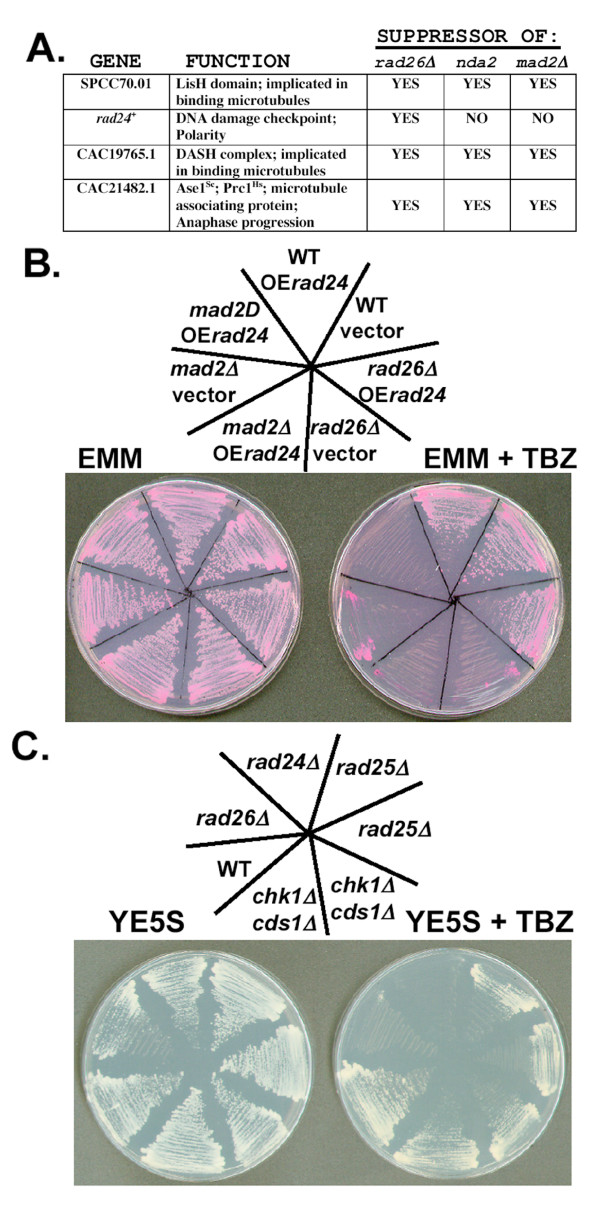
Over expression of rad24 cDNA rescued the TBZ-sensitivity of rad26Δ cells, but not mad2Δ cells. A. Results of the over expression (OE) screen (see Methods). Four cDNAs suppressed the TBZ-sensitivity of rad26Δ cells, and three of these also suppressed the TBZ-sensitivities of nda2KM52 and mad2Δ cells. B. Only OErad24+ specifically suppressed the growth of rad26Δ cells on TBZ. Wild type (TE236), rad26Δ (TE257) and mad2Δ (TW1219) were transformed with a plasmid containing inducible rad24 cDNA (pTW909) and streaked onto EMM and EMM + TBZ medium containing the vital stain Phloxin B. Pictures were taken after 3 days of growth at 30°C. Upper left = EMM; Upper right = EMM + TBZ (20 μg/ml) C. rad24Δ cells were sensitive to TBZ. Wild type (TE236), rad26Δ (TE257), rad24Δ (TE465), rad25Δ (TE464) and chk1Δ cds1Δ (TE892) were streaked onto YE5S (top) and YE5S + 20 μg/ml TBZ (bottom) and incubated at 30°C for three days.